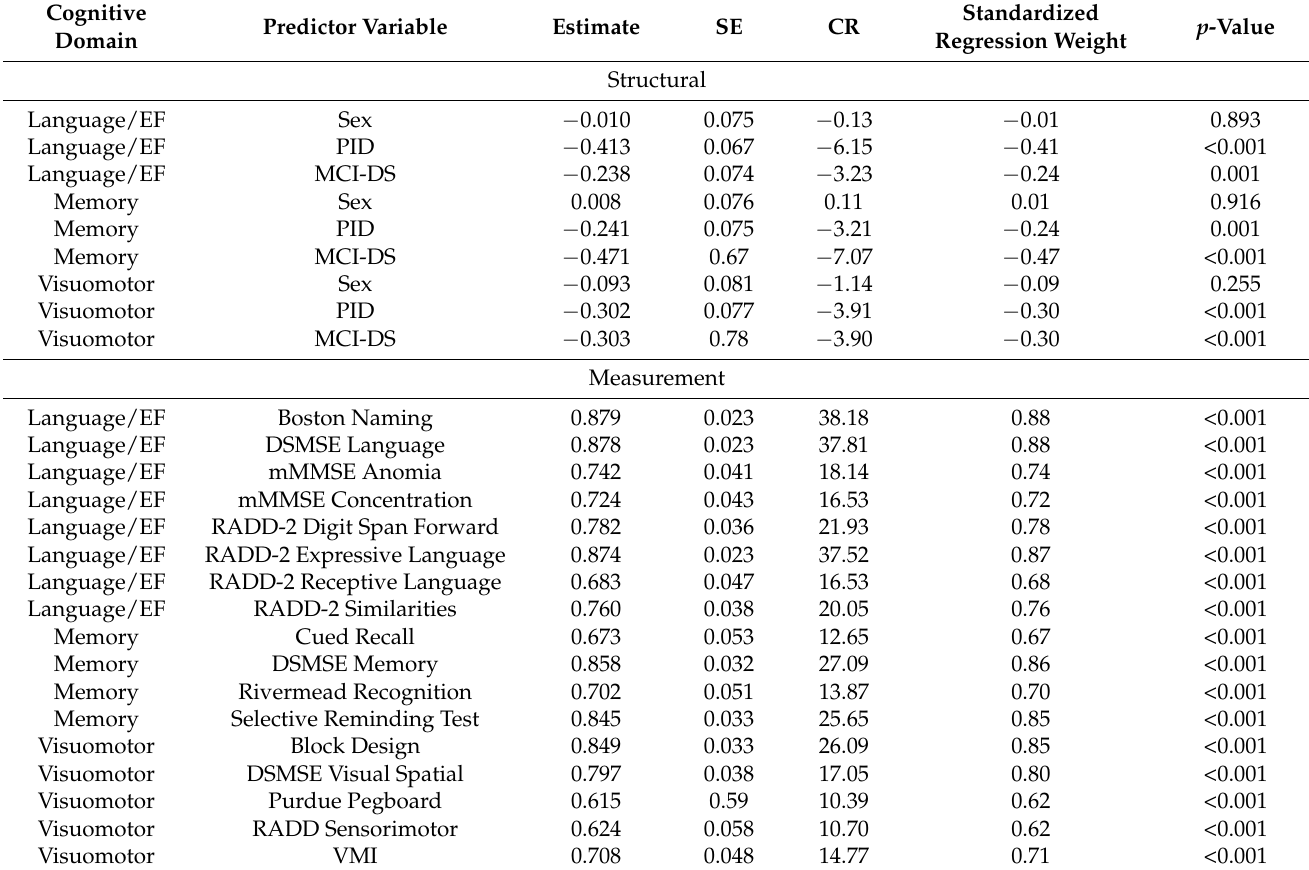
Table 5. The relationship between sex, premorbid ID, MCI-DS, and cognitive